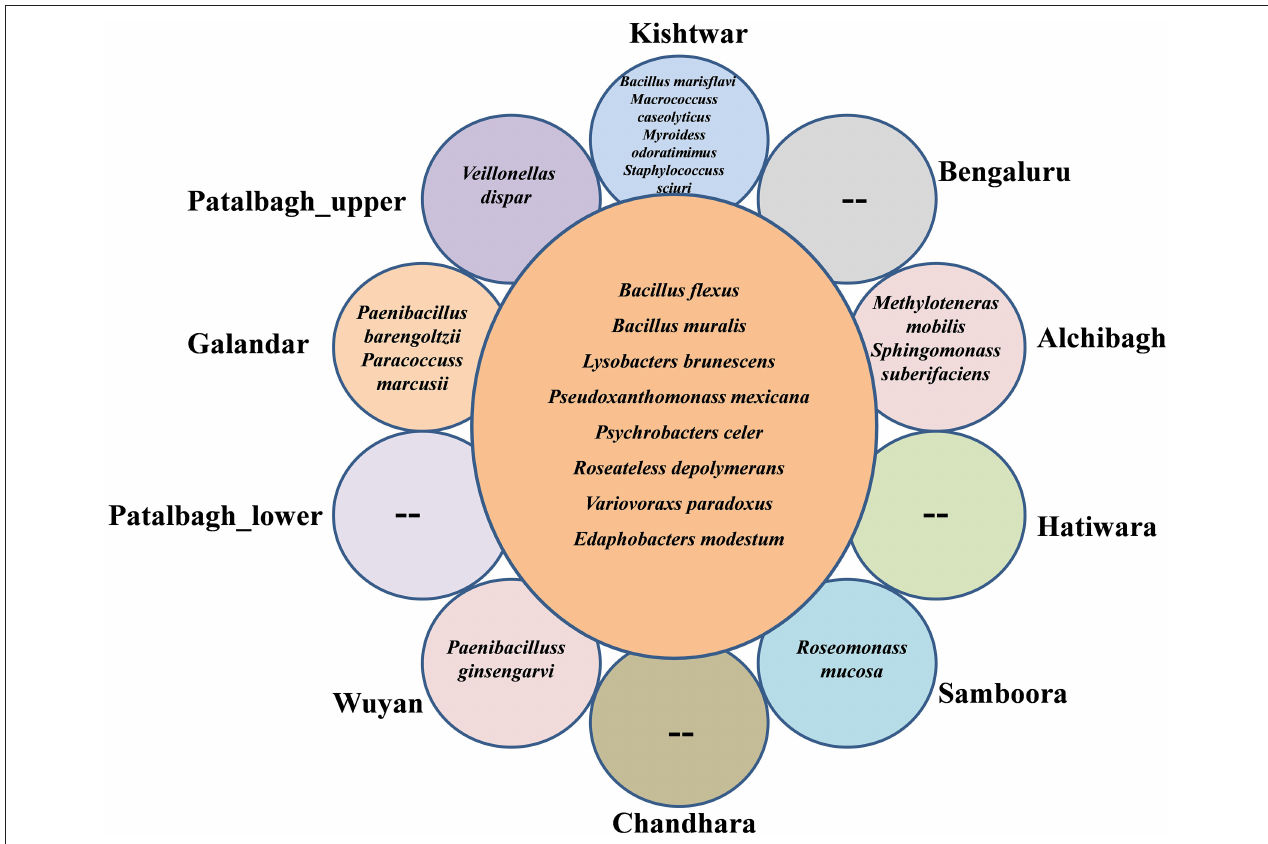
FIGURE 6 | Radical Venn diagram representing the number of unique and common species identified in 10 different locations. 8 common species were identified in 10 samples. Kishtwar had maximum number (4) of unique bacterial species followed by 2 bacterial species each in Alchibagh and Galandar whereas only 1 bacterial species in Patalbagh_upper range, Wuyan and Samboora. Bengaluru, Hatiwara, Chandhara and patalbagh_lower range did not have any unique bacterial species.